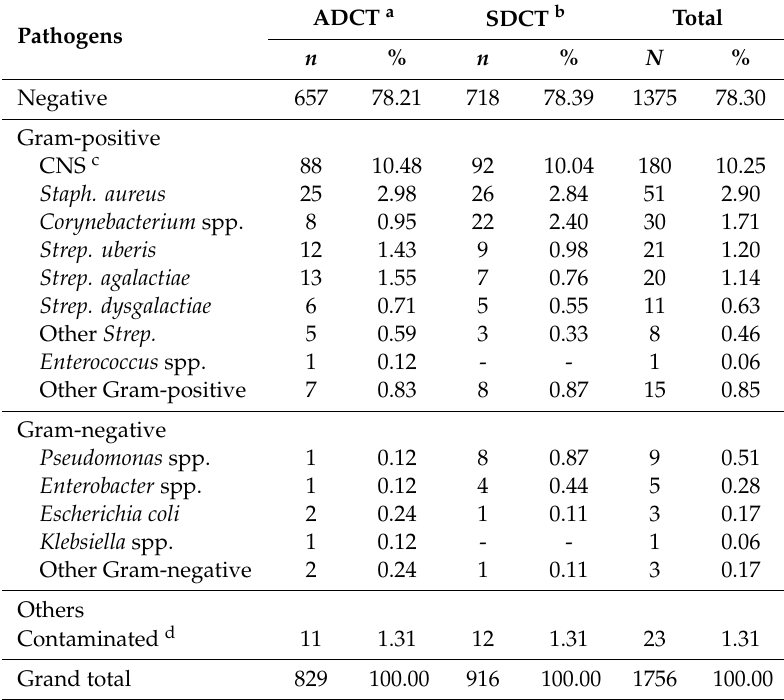
Table 2. Frequency of bovine mastitis pathogens isolated from mammary quarters at drying o ff according to drying o ff